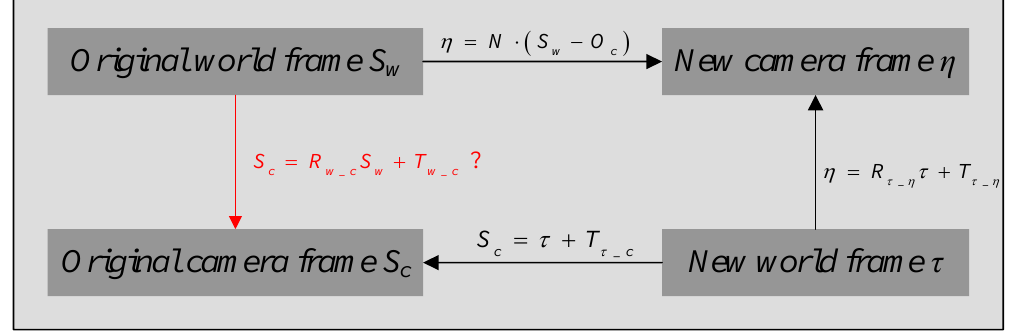
Figure 5. Transformations of the four frames. The question mark there means the transformation between S C and S W is unknown and needs to be computed. This is different from the other transformations, which have been computed.